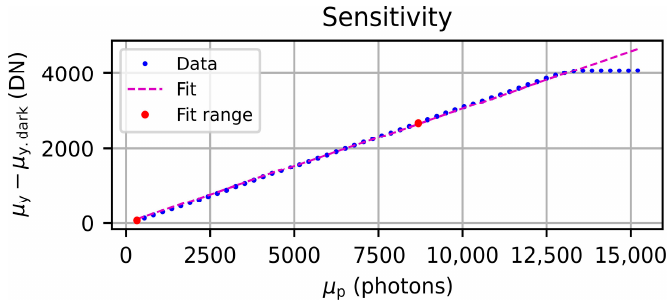
Figure A5. Sensitivity curve for the camera Allied Vision Mako G-419B NIR.